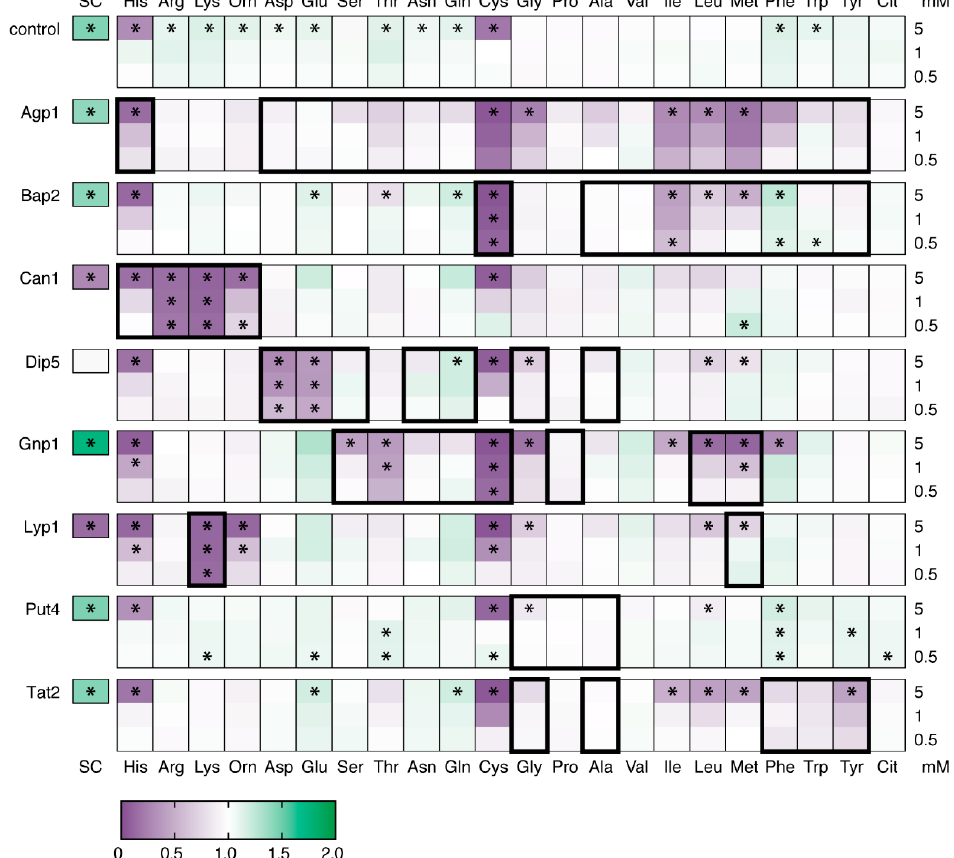
Figure 2. The effect of amino acids on the growth of strains overexpressing amino acid transporters. BY4709 carrying the empty plasmid pRSII426 was used as a control. All proteins were expressed from the constitutive ADH1 promoter with a C-terminal YPet tag. Heat maps show cell density (OD 600 ) after 24 h, normalized such that the same strain in YNBD mini- mal media without amino acids = 1. Raw values are given in Figure S4. The proteinogenic amino acids are represented by their single letter code (see Table 4). Orn = ornithine, Cit = citrulline, SC = synthetic complete media minus uracil. Amino acids were added at final concentrations of 0.5, 1, or 5 mM. Thick black boxes indicate reported substrates for each trans- porter (for references, see Table 1). Asterisks (*) indicate p < 0.05 when compared to growth in YNBD ( t -test).